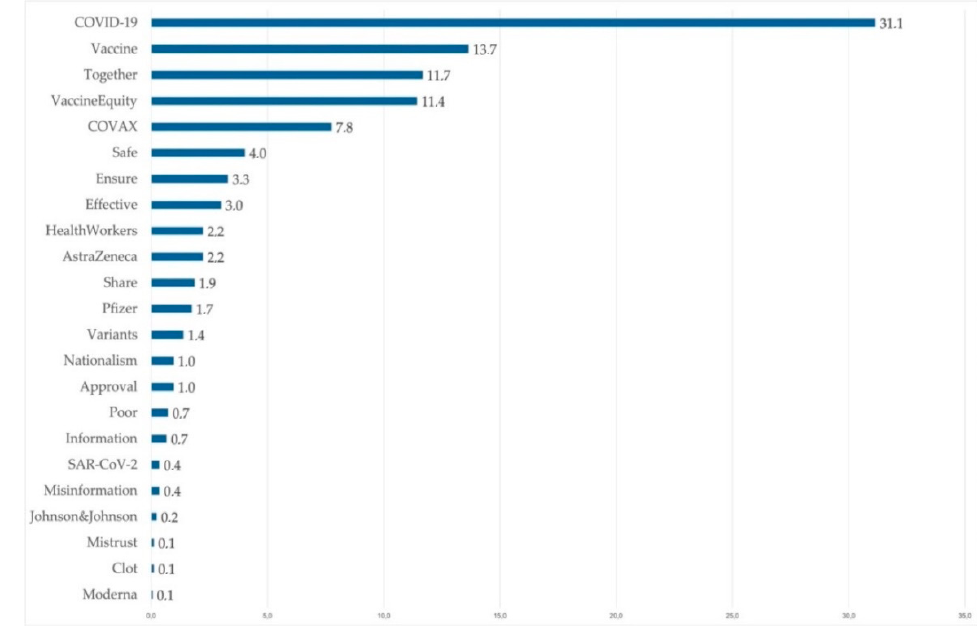
Figure 3. Weight (%) of the main terms included in the messages.